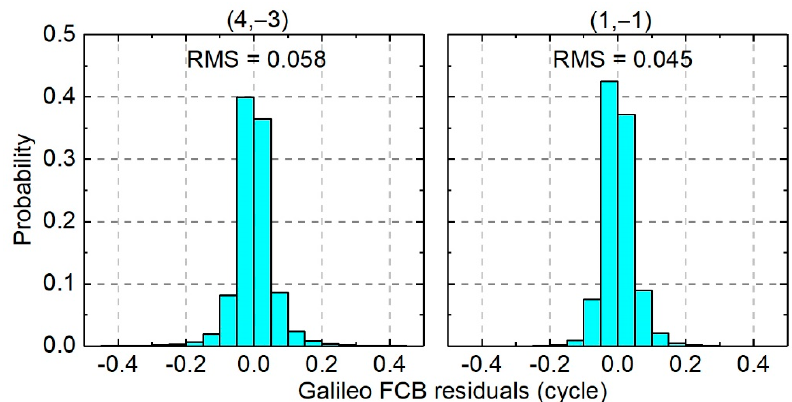
Figure 13. Distribution of the a posteriori residuals of the Galileo FCB estimation with integer linear-combined float ambiguities.